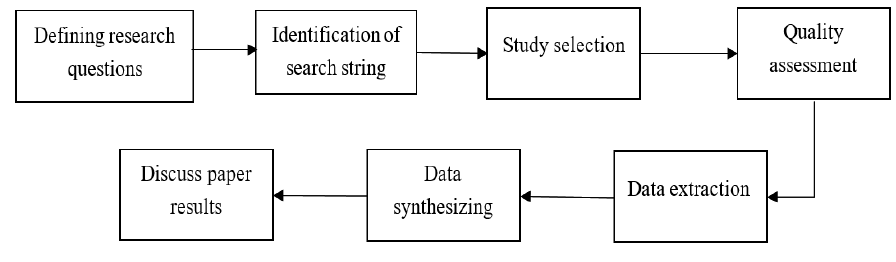
Figure 1. SLR process.